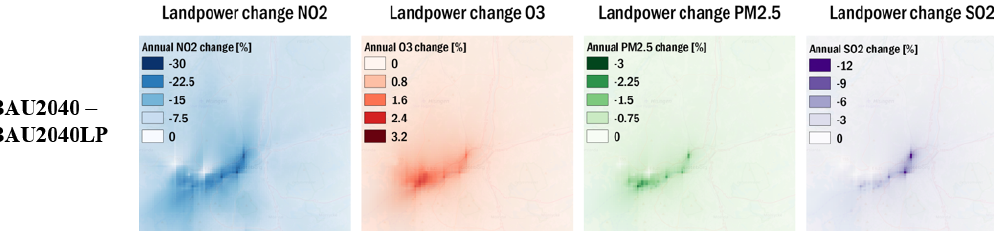
Figure 7. Relative changes in annual mean NO 2 , PM 2 . 5 , and O 3 concentrations for BAU2040LP compared to 2040BAU scenario. © Open- StreetMap contributors 2019. Distributed under a Creative Commons BY-SA